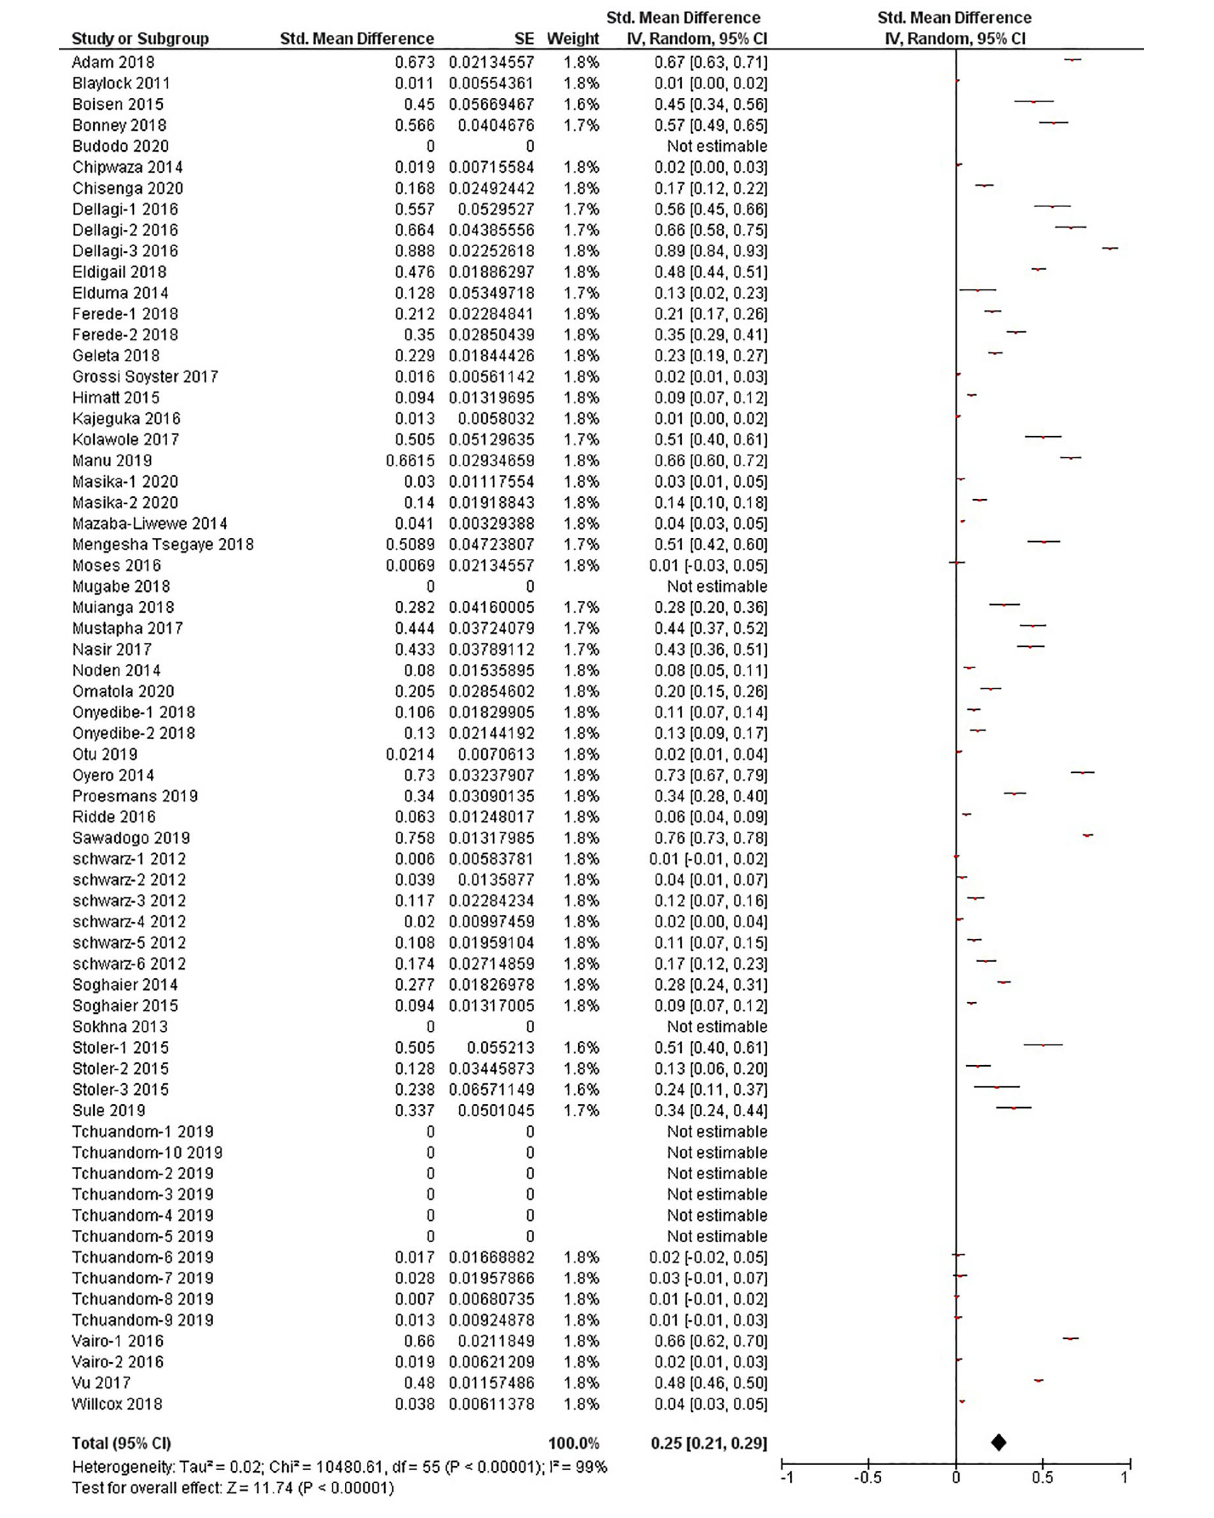
FIGURE 3 | The pooled sero-prevalence of Dengue Virus Immunoglobulin G (IgG) in Sub-Saharan African population between